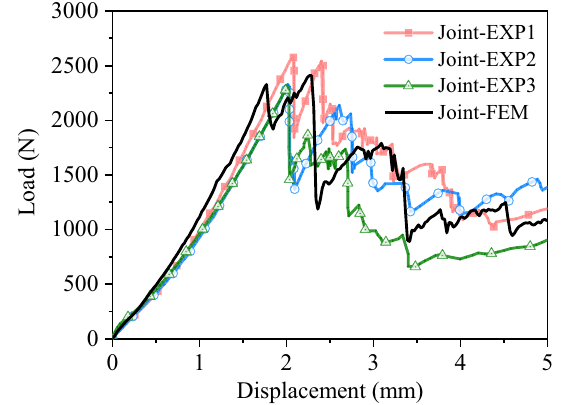
Figure 6 Comparison of load-displacement curves from experiments and finite element method